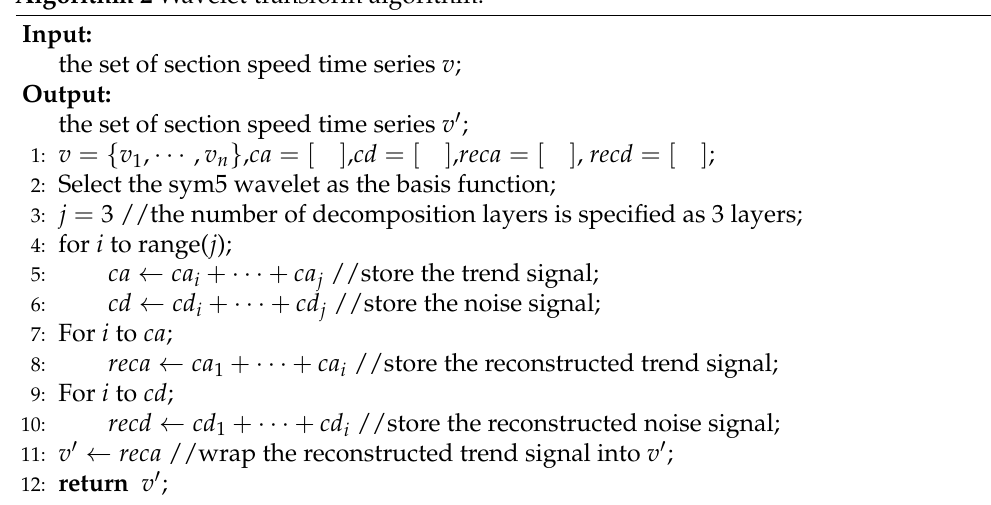
Algorithm 2 Wavelet transform